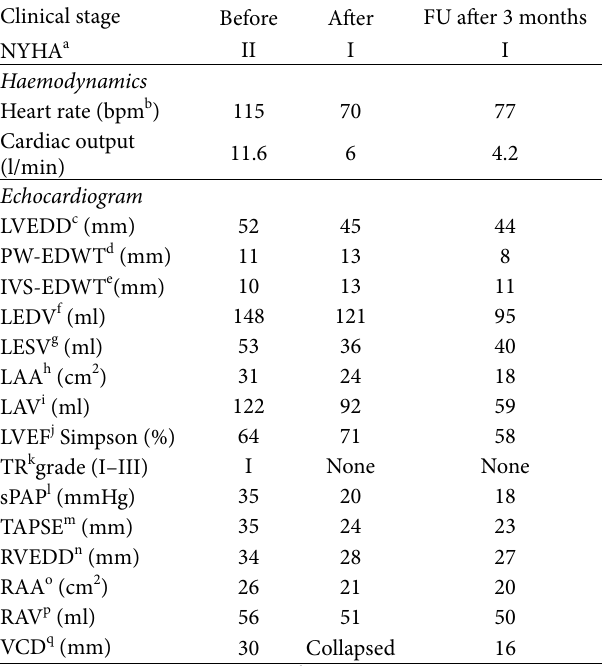
Table 1: Clinical and cardiac parameters before and after the occlusion of the left renal artery (LRA). Listed are relevant clinical haemodyamic and cardiac parameters before, 2-days and 3-months post-surgery with placement of two Amplatzer Vascular Plug (AVP) II devices in the LRA causing the occlusion of the renal arterio- venous fistula